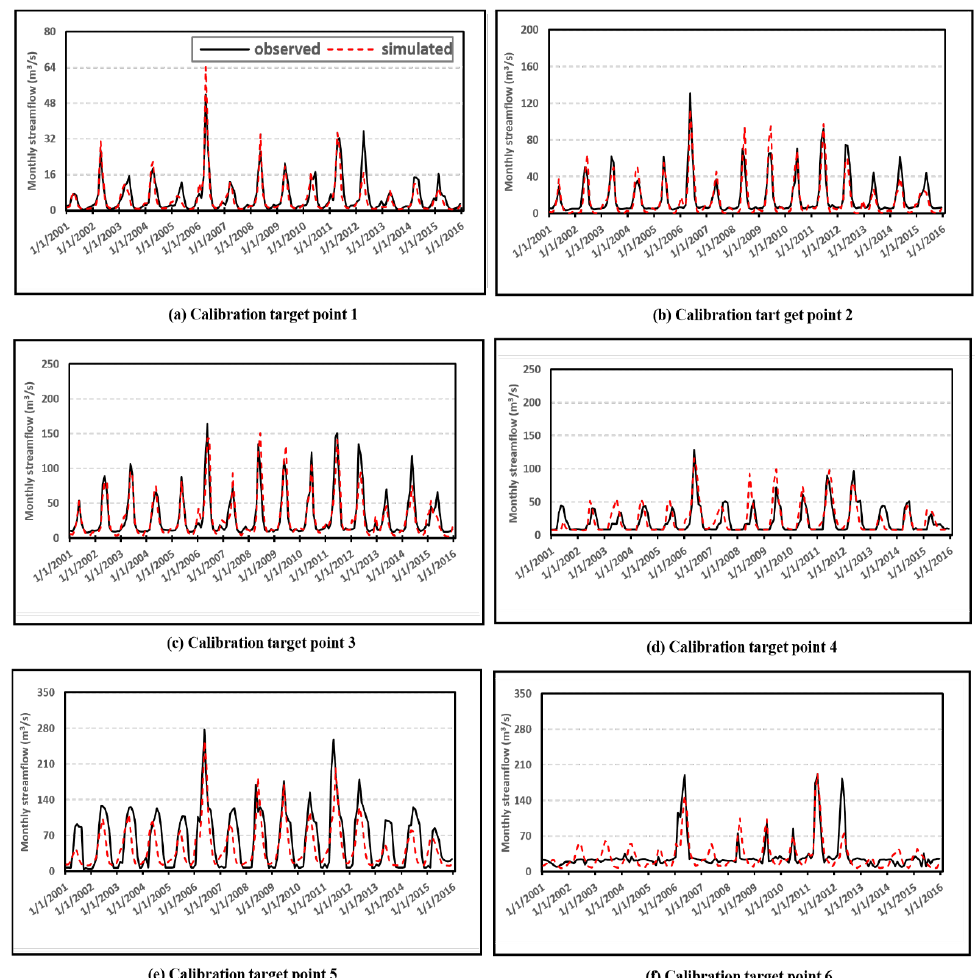
Figure 2. Comparisons of the simulated and observed streamflow at the calibration target points 1–6,